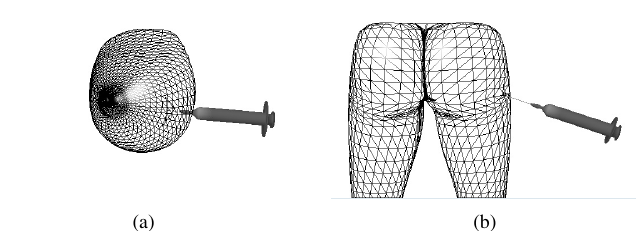
Figure 1. Examples of applications generated by the ViMeT framework: (a) breast and (b) glutes